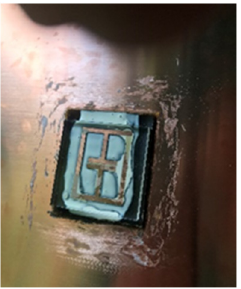
Figure 4. Ecoflex substrate.